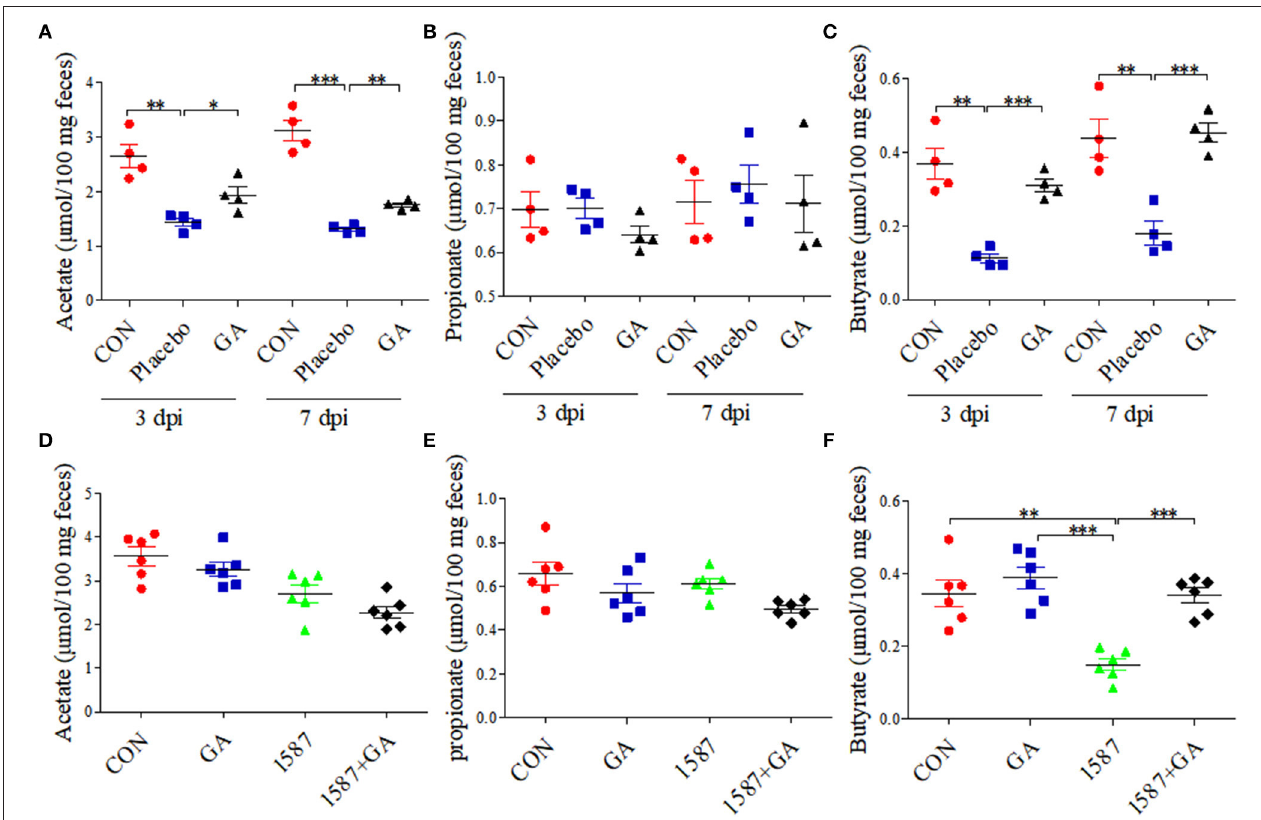
FIGURE 6 | Colonic short-chain fatty acid (SCFA) levels of neonatal mice post oral GA therapy. Concentrations of acetate (A,D) , propionate (B,E) , and butyrate (C,F) upon oral therapy ( n = 4–6 per group). Data were presented as means ± SEM. Statistical significance was analyzed using unpaired t -test. * p ≤ 0.05, ** p ≤ 0.01, *** p ≤